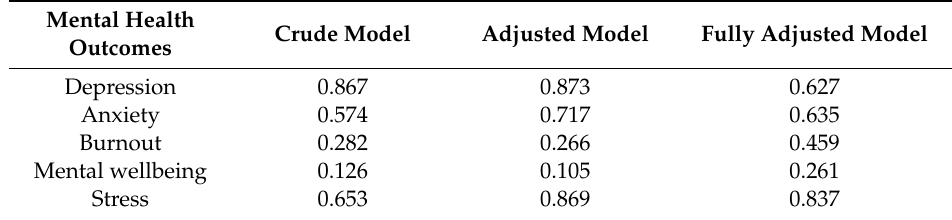
Table 2. The p -values from the ANOVA type II test of deviance of the regression, examining the association of the entire 24 h movement composition with each mental health outcome.